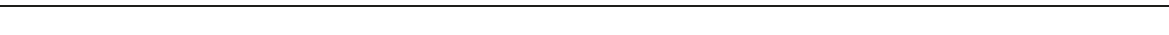
Fig. 4 Top3 β and RISC genetically interact to promote heterochromatin gene silencing by PEV assay. a Representative eye images show suppression of PEV reporter 39C-2 by heterozygous mutant of Top3 β 26 . b Representative eye images (left), and pigment quanti fi cation assay (right), show that double heterozygous mutants of Top3 β 26 / + ; AGO2 321/ + enhanced PEV (white eyes) for the 39C-2 reporter line. c Same as b , except that mutants of Top3 β 26 and AGO1 04845 were analyzed. d Same as a , except that Top3 β and Rm62 mutants were analyzed. e Same as b , except Top3 β and Fmr1 mutants were analyzed. f Same as b , except that Top3 β and Dcr-2 mutants were analyzed. Several images of control and single heterozygous mutants were copied from Fig. 3b for the convenience of readers. The asterisks in graphs mark p -values less than 0.05 by Student T -test. n.s. represents statistically non-signi fi cant p values ( p > 0.05). The error bars are obtained by standard error method. The results are obtained from three independent